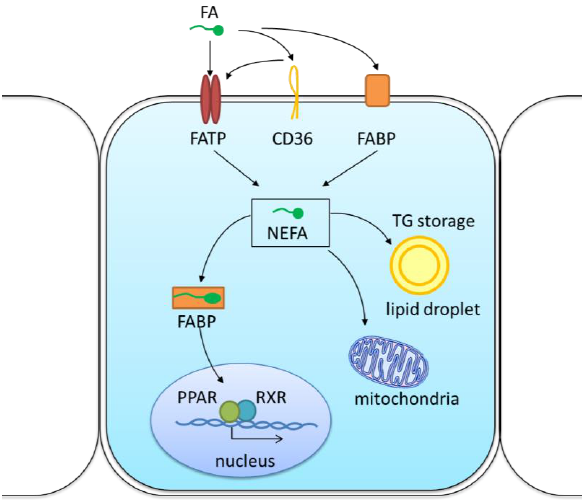
Figure 2. Schematic representation of fatty acids cellular uptake in the kidneys. FA transport across the plasma membrane occurs mainly by protein-mediated mechanisms either with CD36 or with FATPs. In the cells, FAs bind to different FABPs with respect to the subcellular localization and have multiple functions in energy generation and storage, membrane synthesis and activation of nuclear transcription factors like PPAR/RXR. NEFA, non-esterified fatty acid; FATP, fatty acid transport protein; FABP, fatty acid-binding protein; PPAR, peroxisome proliferator activated receptor; RXR, retinoid X receptor; TG,